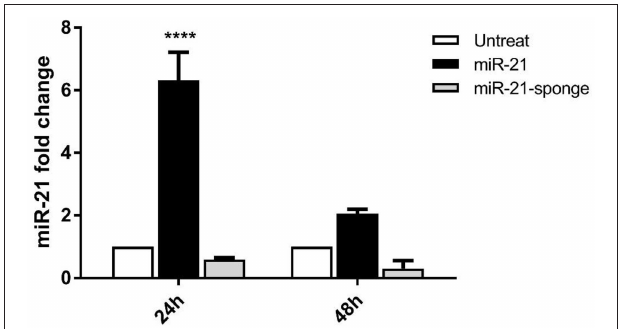
FIGURE 2 | miR-21 expression level in U87-MG cells, after 24 and 48h of co-culture with HEK-293T cells stably expressing pri-miR-21 or miR-21-sponge cells. The results revealed a potential transfer of miR-21 and miR-21-sponge from HEK-293T to U87-MG cells via conditioned media. **** P < 0.0001, which is represented by some statistical software like Graph